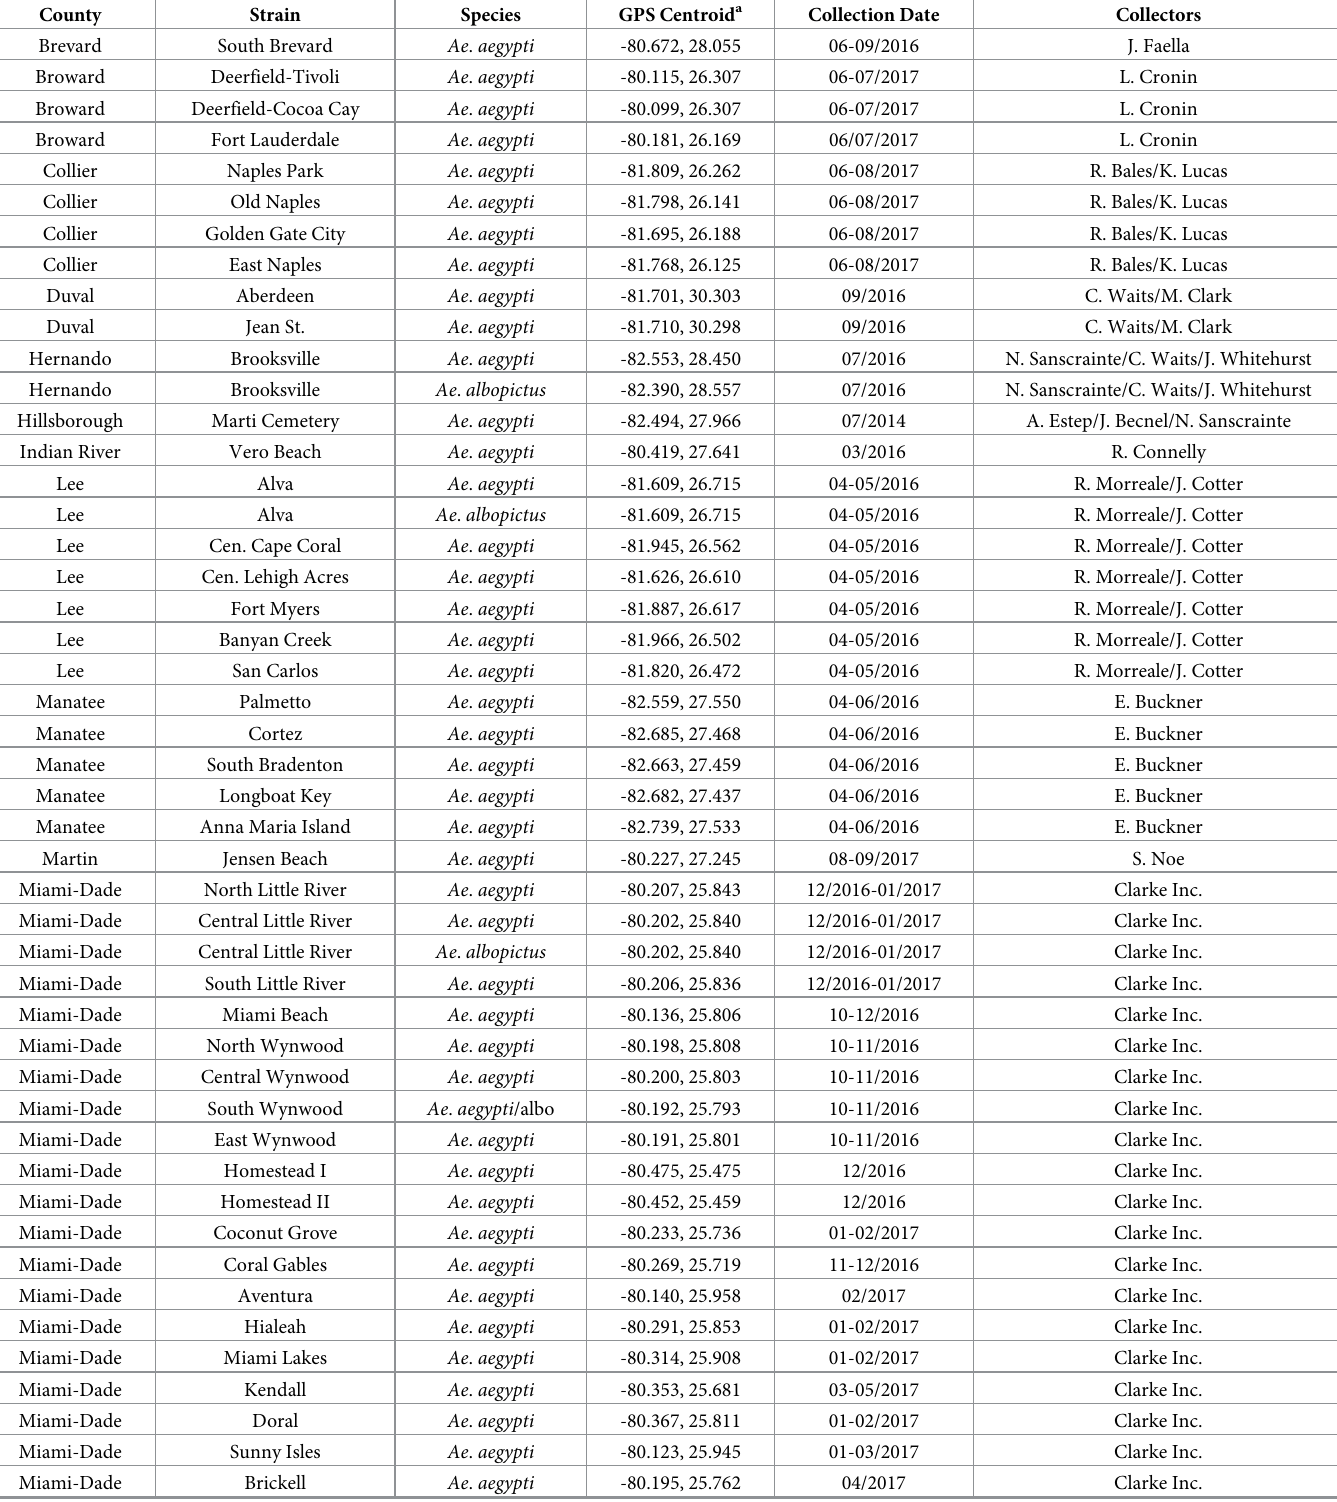
Table 1. Collection information for Florida Aedes aegypti and Ae . albopictus used in this study.